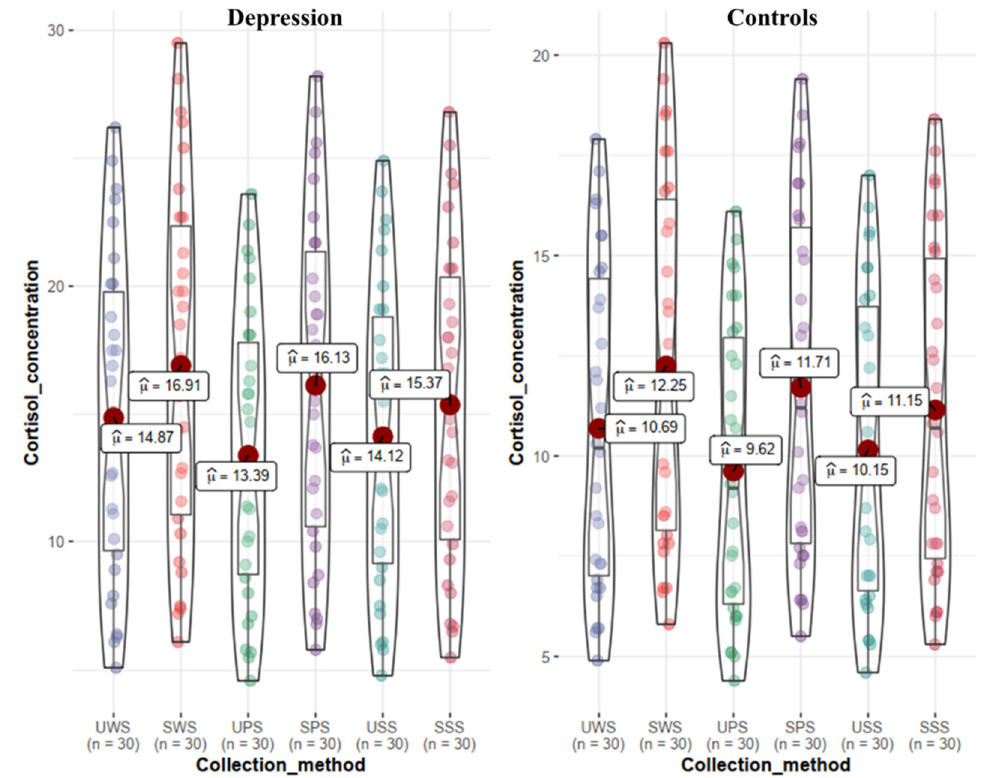
Figure 3. Saliva cortisol levels in the patient group and the control group.